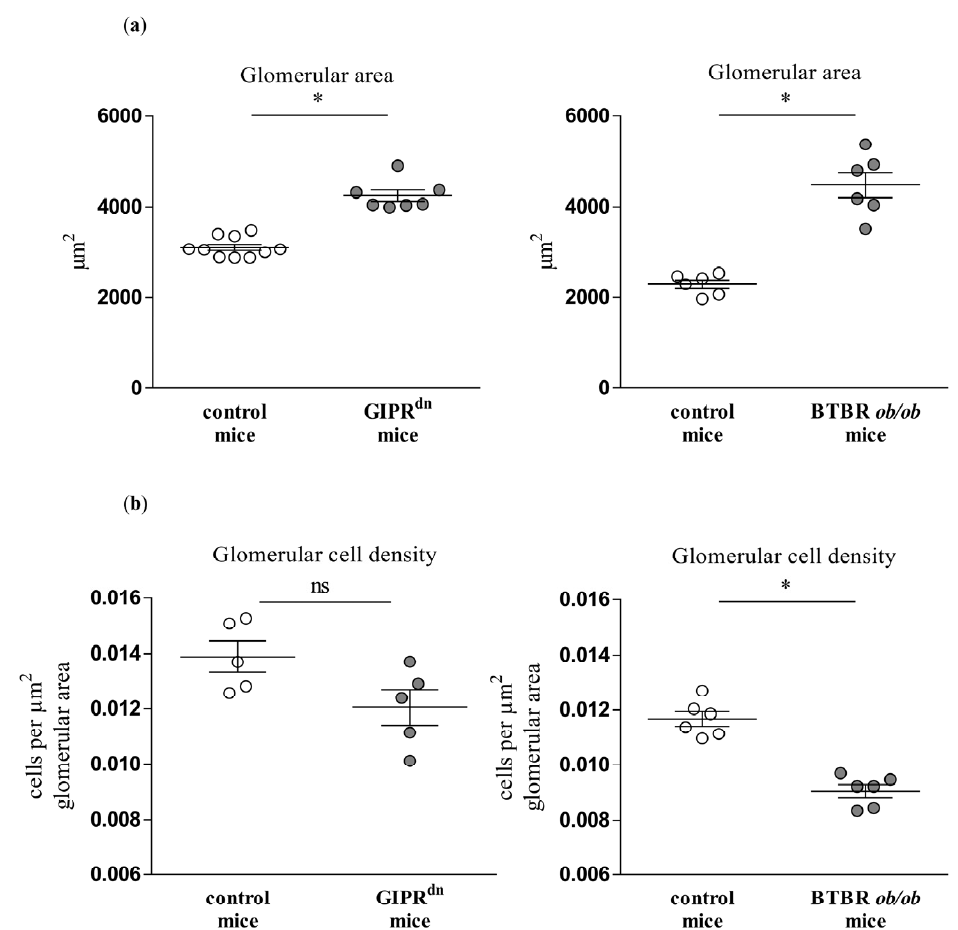
Figure 6. Analysis of glomerular morphology in diabetic kidney disease models. Automatic histological evaluation of glomerular area ( a ) and glomerular cell density ( b ) in kidneys of GIPR dn mice ( left , diabetes mellitus type 1 model) and BTBR ob/ob mice ( right , diabetes mellitus type 2 model) compared to their corresponding healthy control mice. Scatter dot plot with means and SEM, * p < 0.05, ns: not significant, n =